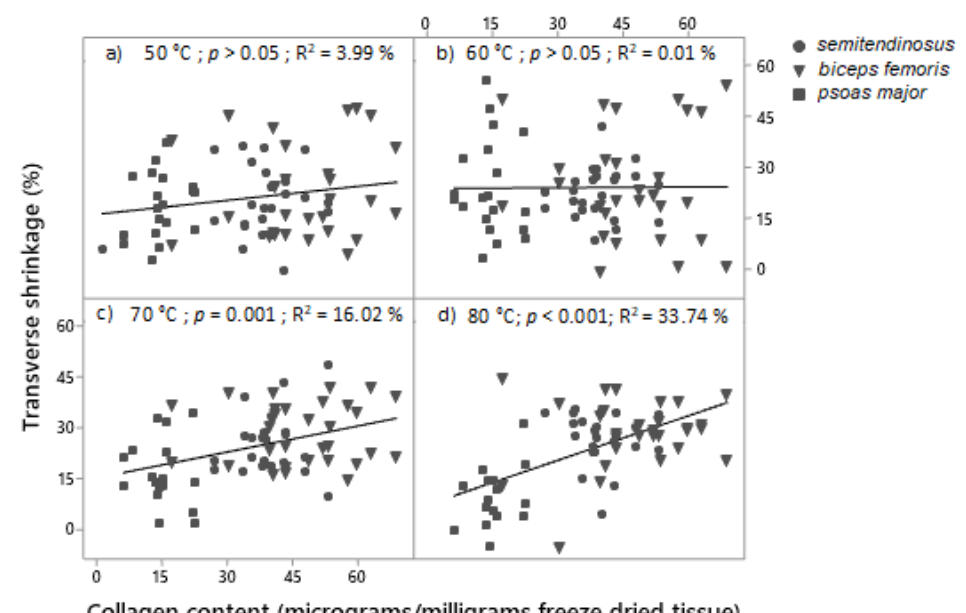
Figure 7. Regression analysis of the relationship between transverse shrinkage and collagen content. Samples cooked at ( a ) 50 °C, ( b ) 60 °C, ( c ) 70 °C, ( d ) 80 °C for 30 min (T c + 30 min.). The p -value presents the significance of the regression, R 2 is percent variance of transverse shrinkage explained by collagen content.